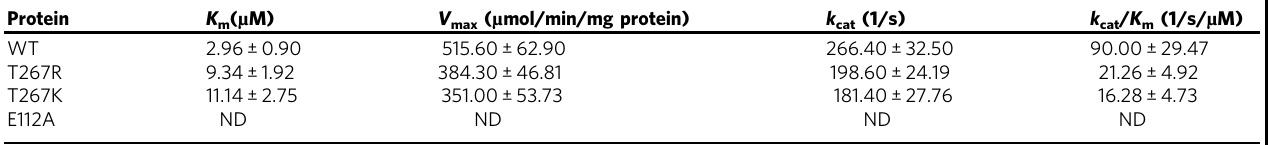
Values are mean plus or minus SEM ( n = 3 independent experiments). Fitted Michaelis – Menten plots are shown in Fig. 5a PAR poly-ADP-ribose, WT wild type, ND no enzymatic activity